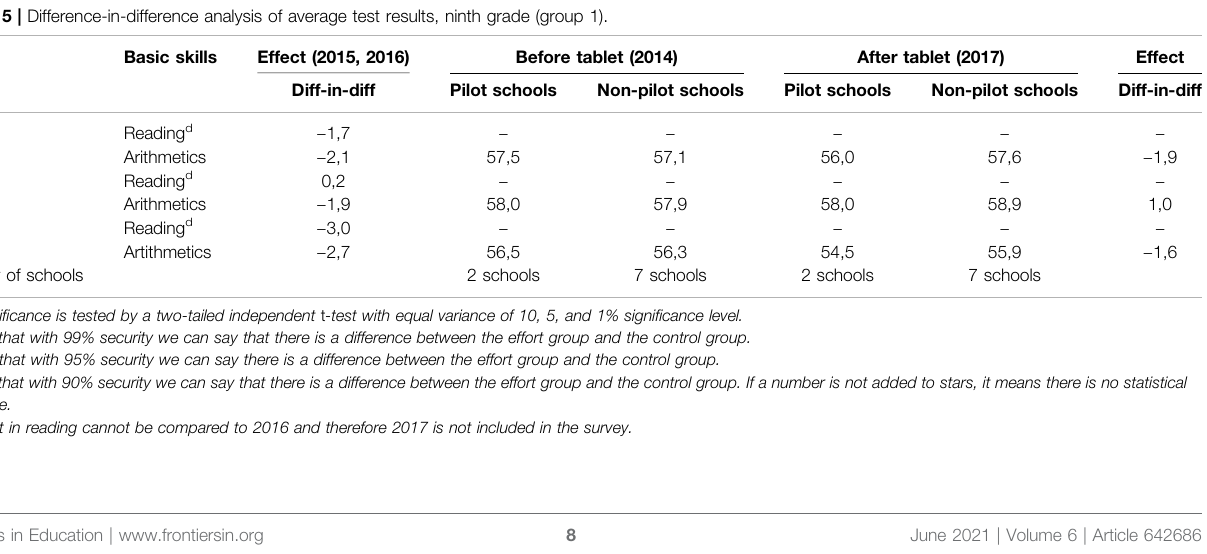
reading, mathematics, and English for all children, boys and